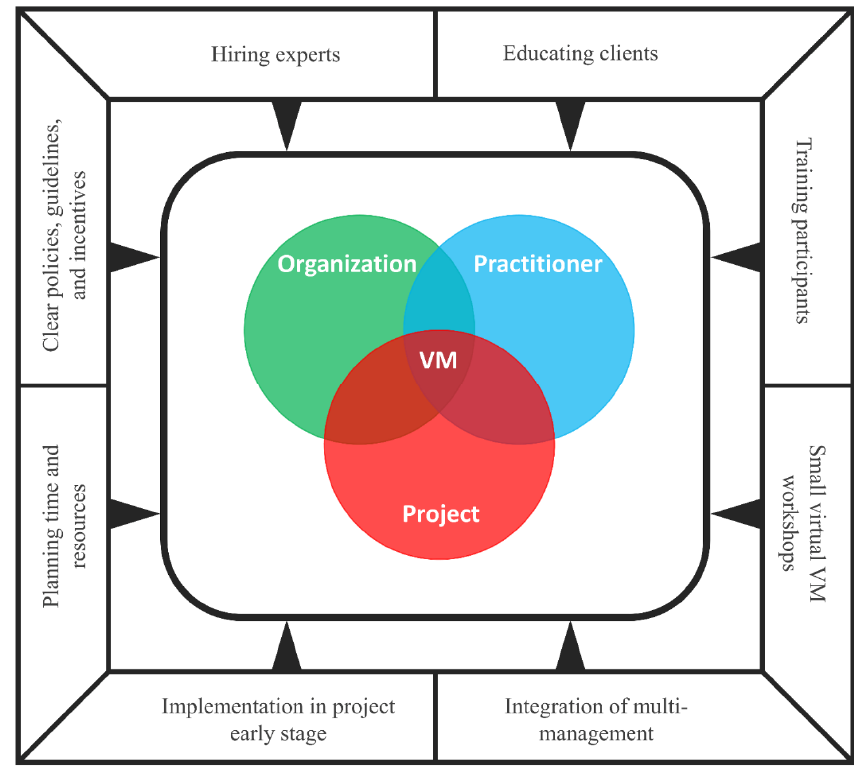
Figure 3. Schematic to promote VM in small and medium construction projects.